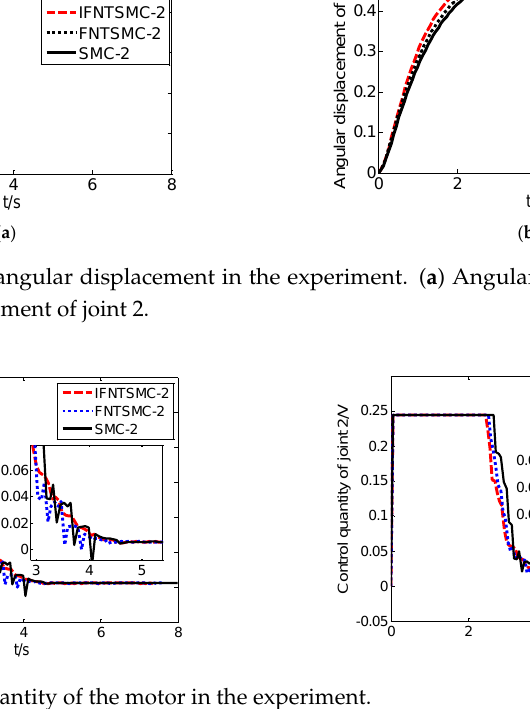
Figure 9. Control quantity of the motor in the experiment. Figure 10. End deformation in the experiment. Table 4. Comparison of control methods. Method